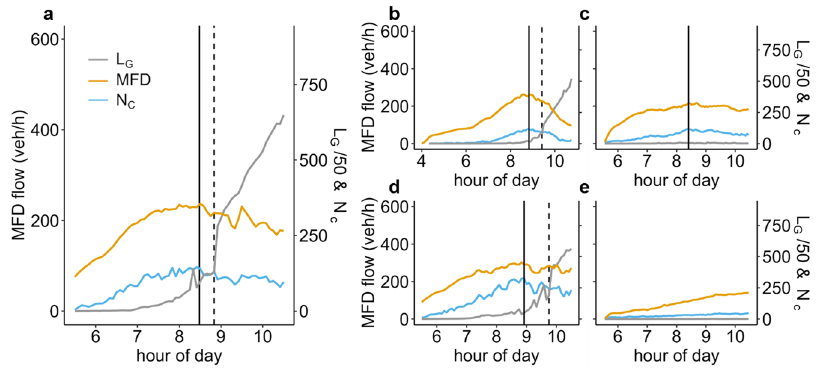
Fig. 4 Comparison of the macroscopic fundamental diagram (MFD) and traf fi c congestion spreading. This fi gure depicts the temporal evolution of the size of the largest cluster ( L G , gray), the MFD fl ow (veh/h-lane, yellow), and the number of congested clusters ( N c , blue) for a selected random seed in a San Francisco, b Rio de Janeiro, c Boston, d Los Angeles, and e Lisbon. The solid vertical line indicates the time at which the maximum number of clusters emerge, which coincides with the time at which the MFD reaches its maximum fl ow; the dashed line indicates when the system